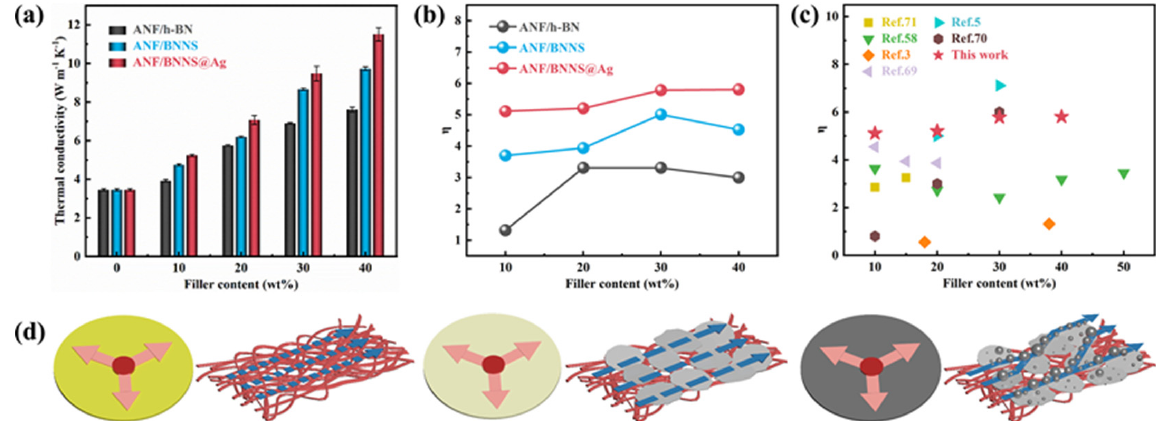
Figure 4. ( a ) Thermal conductivity of the different composite films. ( b ) Thermal conductivity enhancement factors of the different composite films. ( c ) Comparison of thermal conductivity enhancement factors of this work and other reports. Schematic diagrams of thermal conducting models in the ( d ) pure ANF, ANF/BNNS, and ANF/BNNS@Ag composite films.